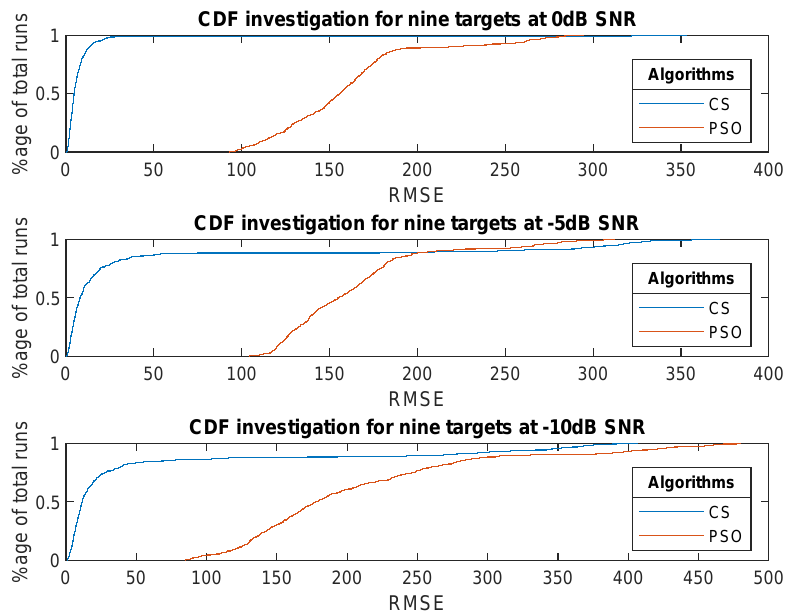
Figure 14. RMSE investigation in terms of CDF using nine targets for various values of